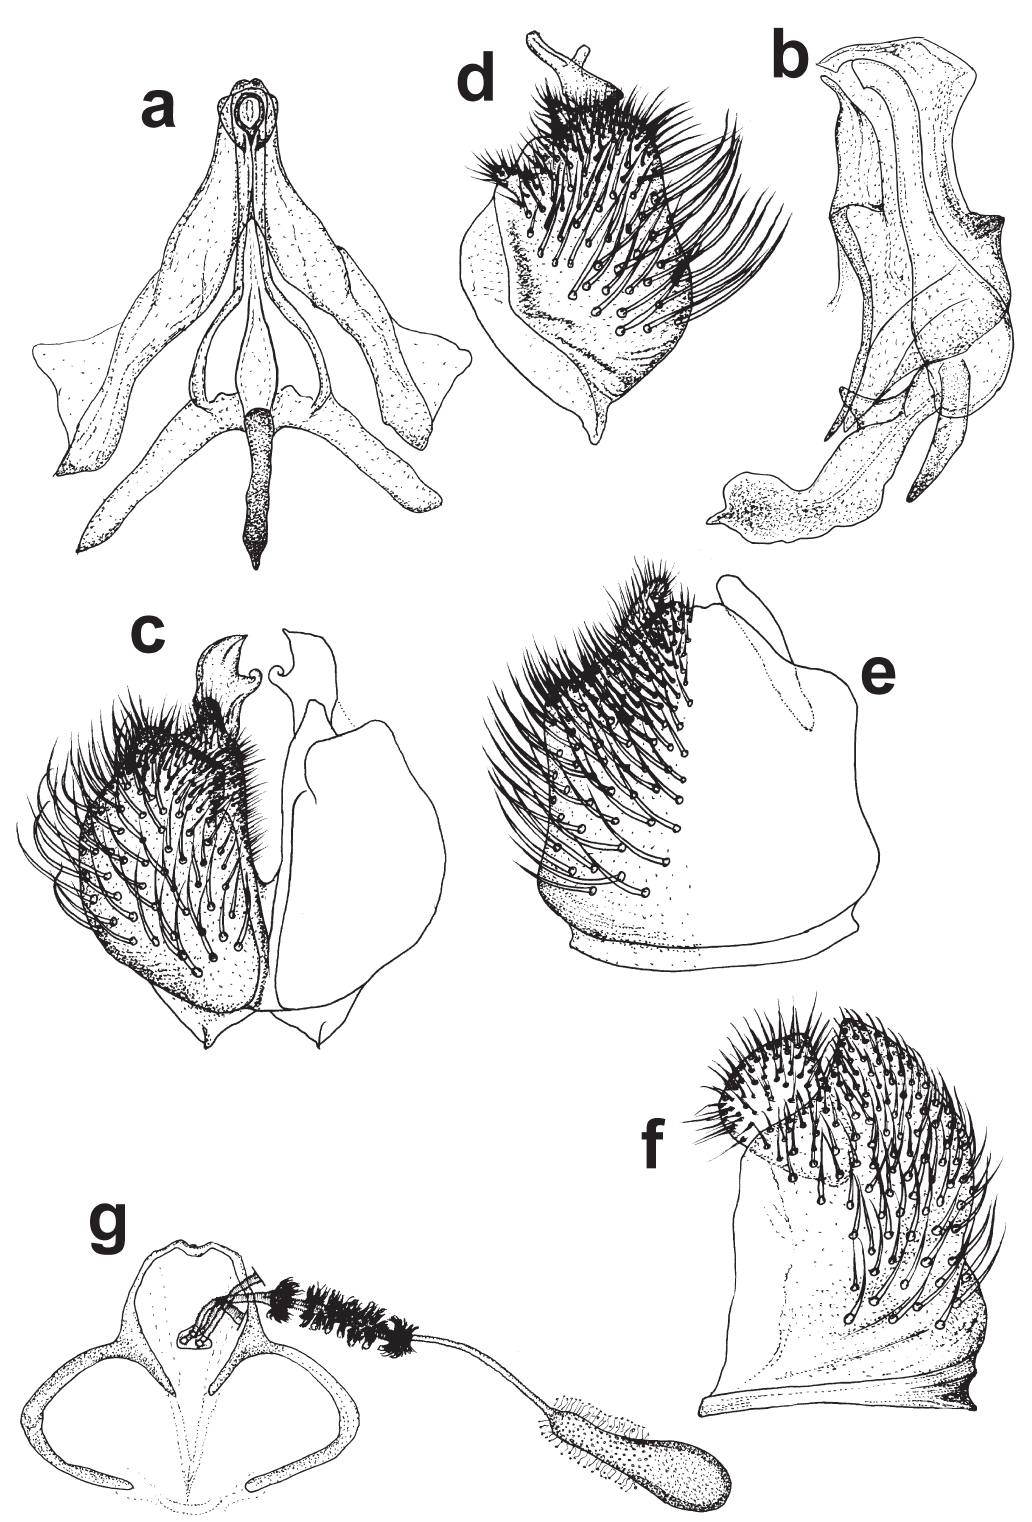
Fig. 33. Ectopusia additivaneura (Carles-Tolrá, 2009) gen. et comb. nov. a . Epiphallic complex ventral. b . Epiphallic complex lateral. c . Gonocoxite ventral. d . Gonocoxite lateral. e . Epandrium dorsal. f . Epandrium lateral. g . Female genitalia